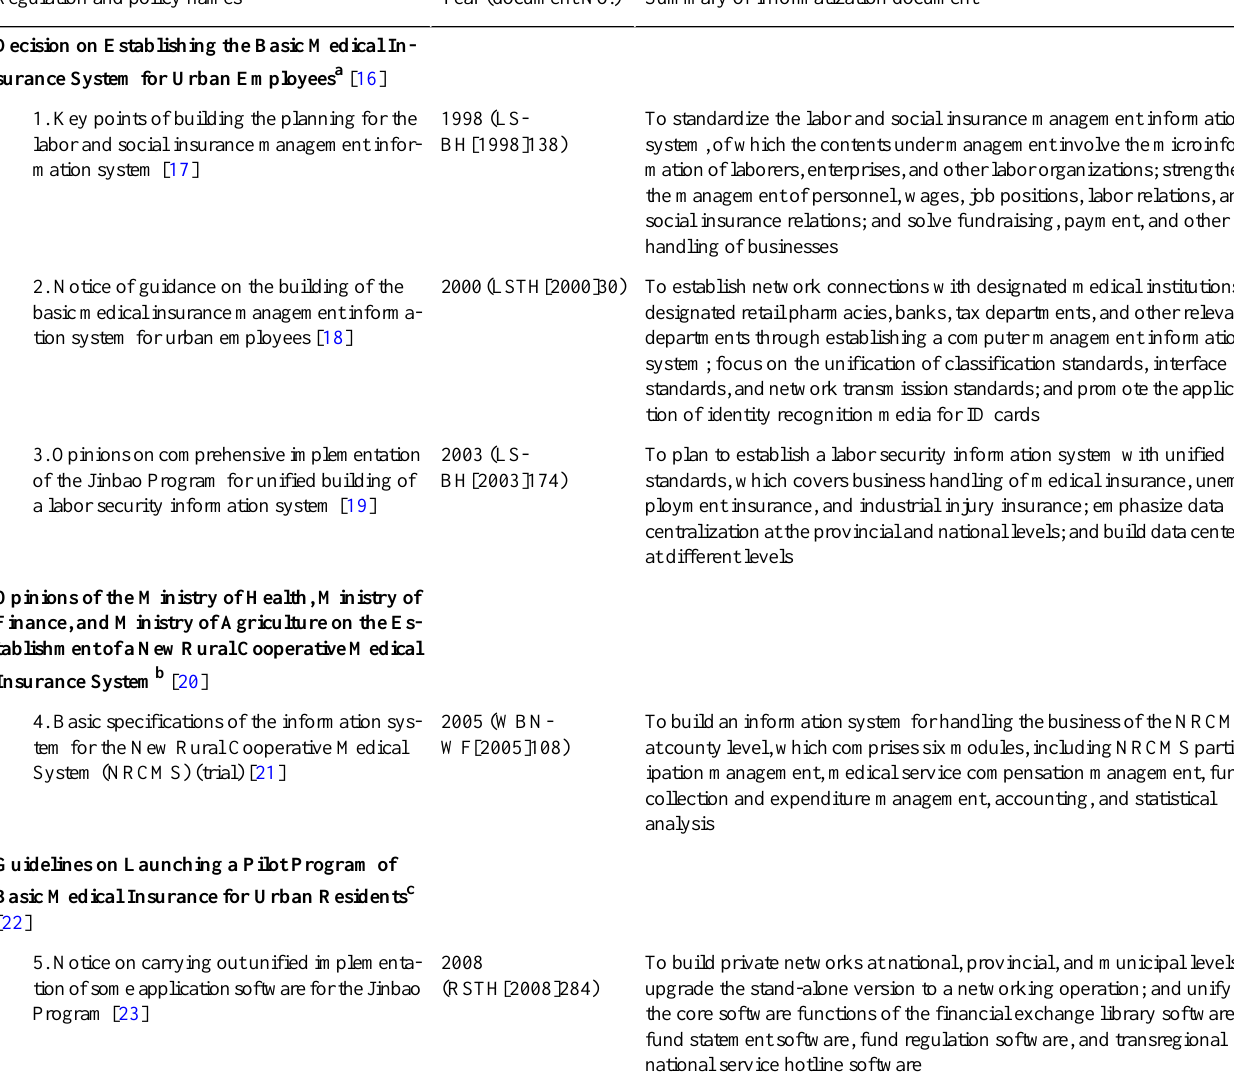
Summary of informatization documentYear (document No.)Regulation and policy